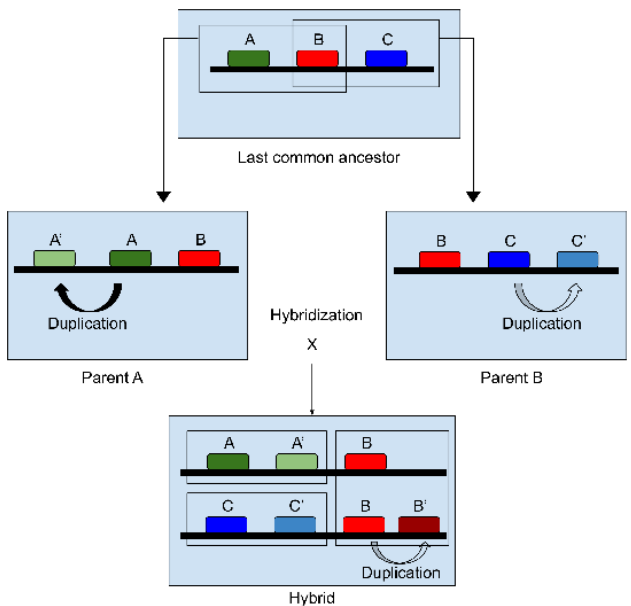
Figure 3. Hybrid homolog genes hypothetic origins: Parent A and parent B can share one-to-one orthologs (i.e., gene B in red box) inherited from their last common ancestor after speciation. Parent A and parent B evolved and accumulated paralogs from duplication events (i.e., genes A and A’ in parent A, and genes C and C’ in parent B). After hybridization, the hybrid genome can inherit paralogs from each parent (i.e., A and A’, C and C’), but also orthologs (i.e., gene B) that share a high percentage of homologs and same function. Duplication events occur in the hybrid genome (i.e., B and B’).